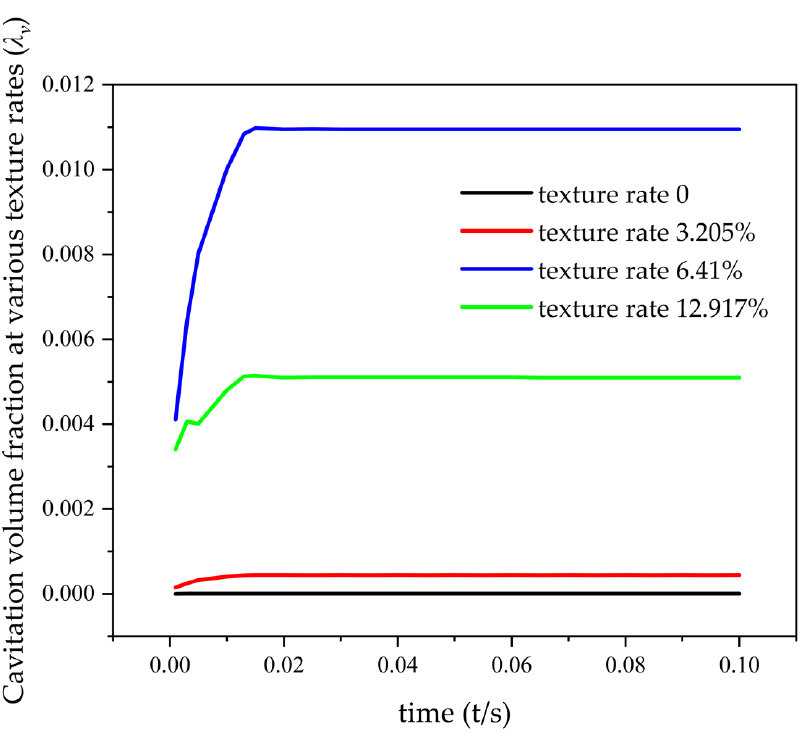
Figure 9. Cavitation volume fraction at various texture rates.